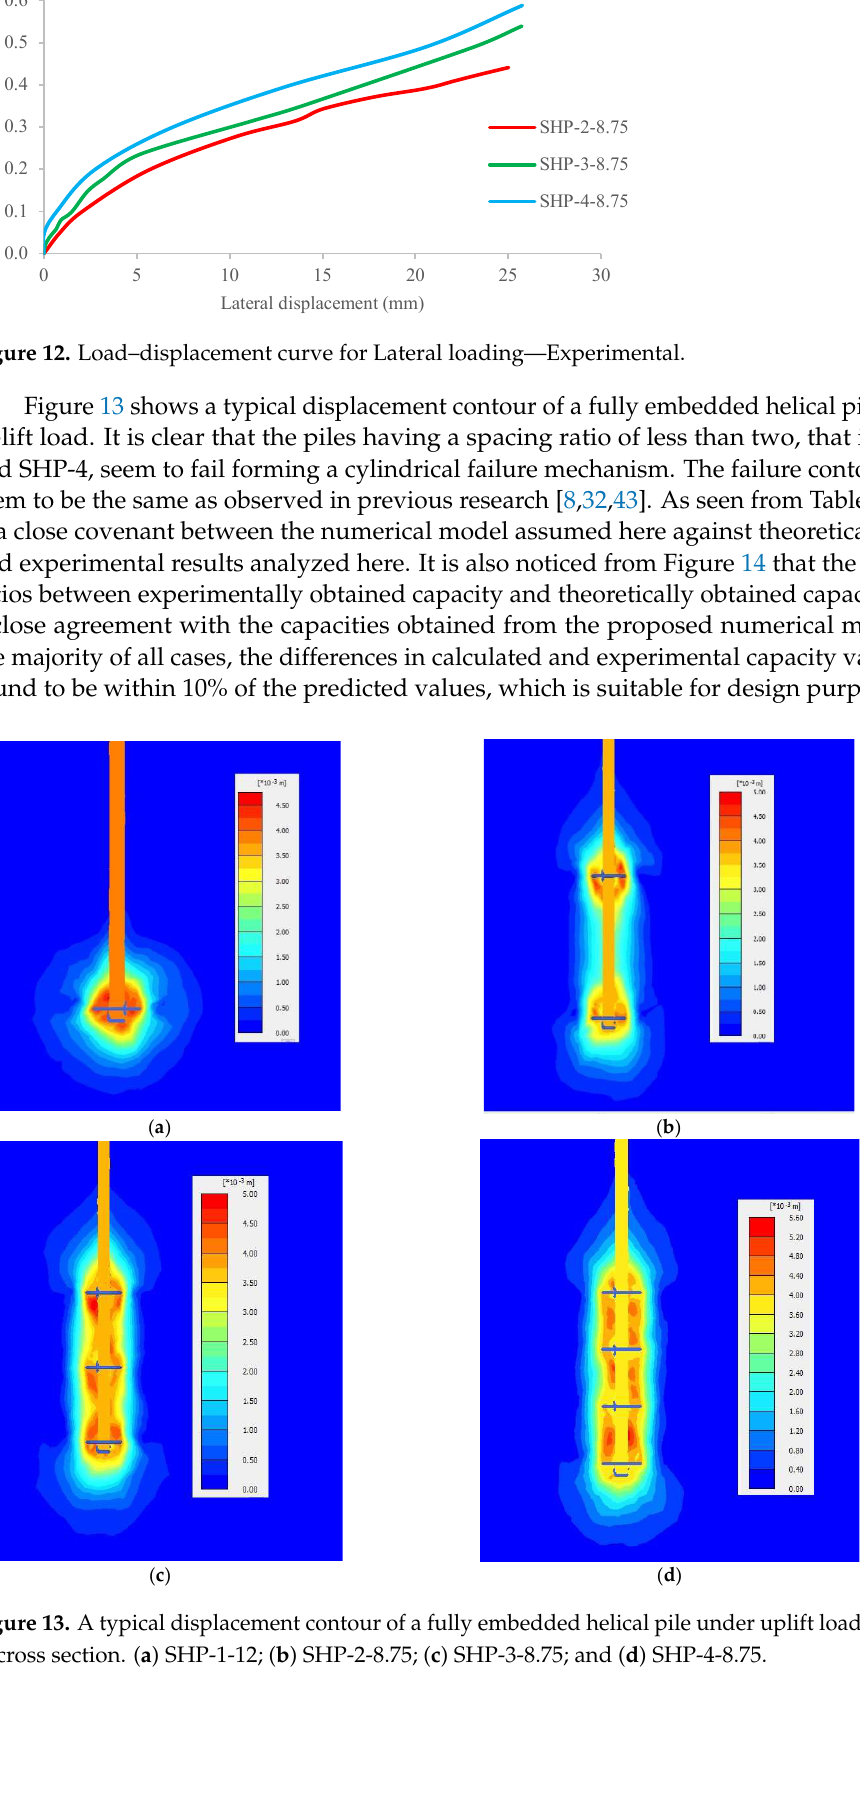
Figure 11. Comparison between Experimental and Numerical results—Uplift loading, ( a ) H/D = 6; and ( b ) H/D = 8.75.